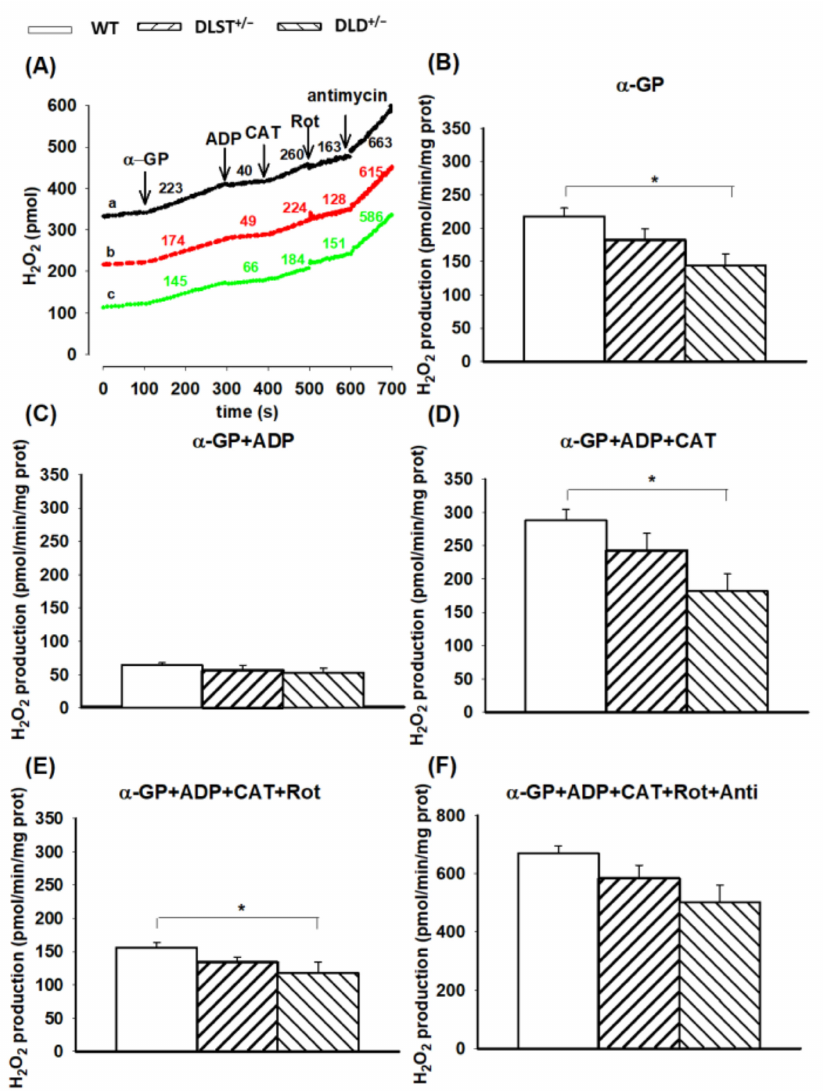
Figure 6. Hydrogen peroxide production in the wild-type and KGDHc-subunit-KO mitochondria respiring on α -glycerophosphate. H 2 O 2 production was measured with the Amplex UltraRed assay as described under Materials and Methods. ( A ) Traces represent a single independent experiment and are offset for clarity. Trace a (black): wild-type (WT), trace b (red): DLST +/ − , trace c (green): DLD +/ − . Mitochondria (0.1 mg/mL) were incubated in the standard medium. Afterwards, α -GP (20 mM), ADP (2 mM), and carboxyatractyloside (CAT; 2 µ M), rotenone (Rot; 250 nM), and antimycin A (2 µ M) were given as indicated. Numbers on the traces represent H 2 O 2 production expressed in pmol/min/mg protein. H 2 O 2 production was measured in the presence of α -GP ( B ), after adding ADP ( C – F ), CAT ( D – F ), rotenone ( E , F ) and antimycin A ( F ). All other conditions and representations are as in Figure 1. Statistically significant differences are indicated by asterisks; * p <